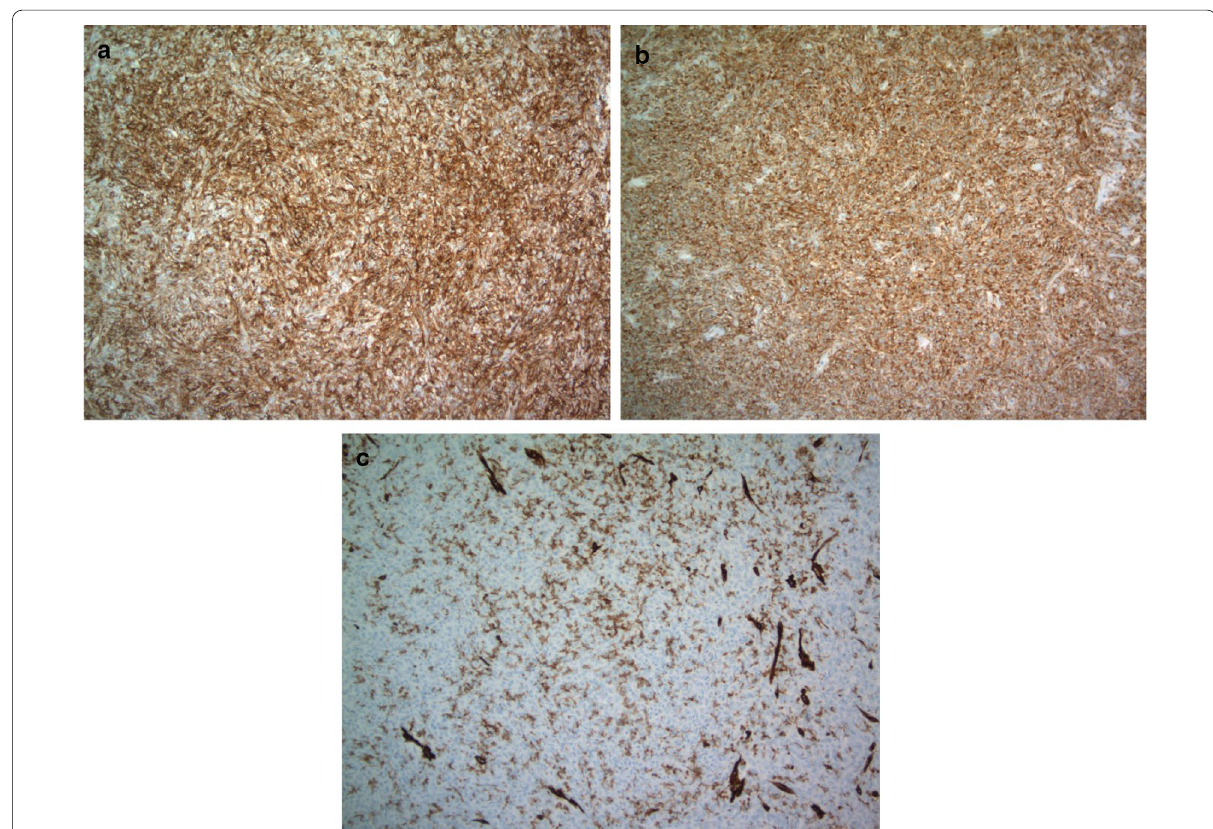
Fig. 4 Immunohistochemical test ( 100 magnification power): immunohistochemical test showing the tumor was positive for CD34 ( a ), and bcl-2 + ( b ), and negative for CD31 ( c